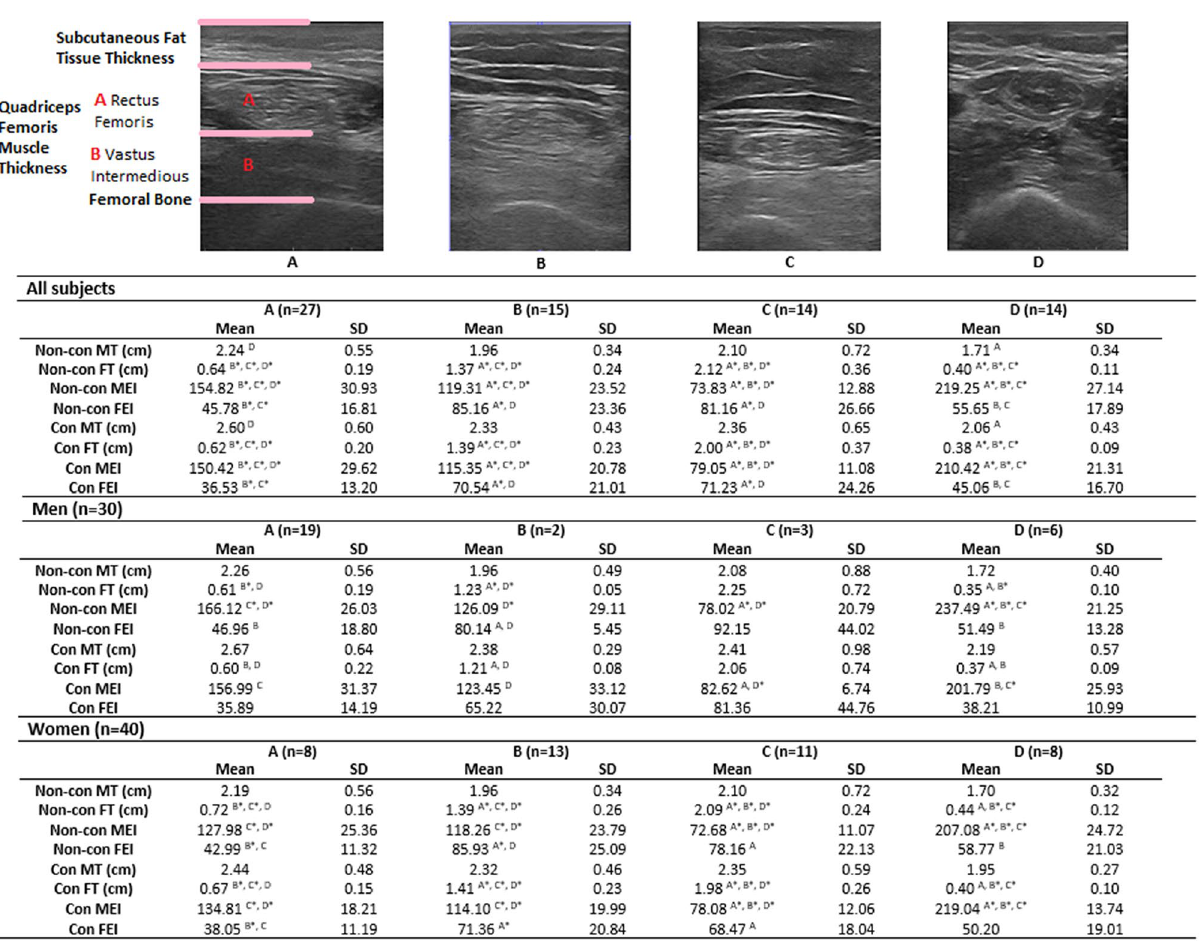
Figure 1. Ultrasound imagesof the four types classified based exploratory hierarchical cluster: ( A ) normal MT, FT, MEI and FEI; ( B ) increased FT, relatively decreased MT to FT, slightly high FEI and slightly low MEI; ( C ) very increased FT, normal MT, decreased MEI and slightly high FEI; ( D ) decreased FT and MT and very high MEI with normal FEI. Non-con MT: Non-concentration muscle thickness; Non-Con FT: Non-concentration subcutaneous fat tissue thickness; Non-con MEI: Non-concentration muscle echo-intensity; Non-Con FEI: Non-concentration subcutaneous fat tissue echo-intensity; Con MT: concentration muscle thickness; ConFT: concentration subcutaneous fat tissue thickness; Con-MEI: concentration muscle echo-intensity; Con-FEI: concentration subcutaneous fat tissue echo-intensity. A,B,C,D p < 0.05; A*, B*, C*, D* p <